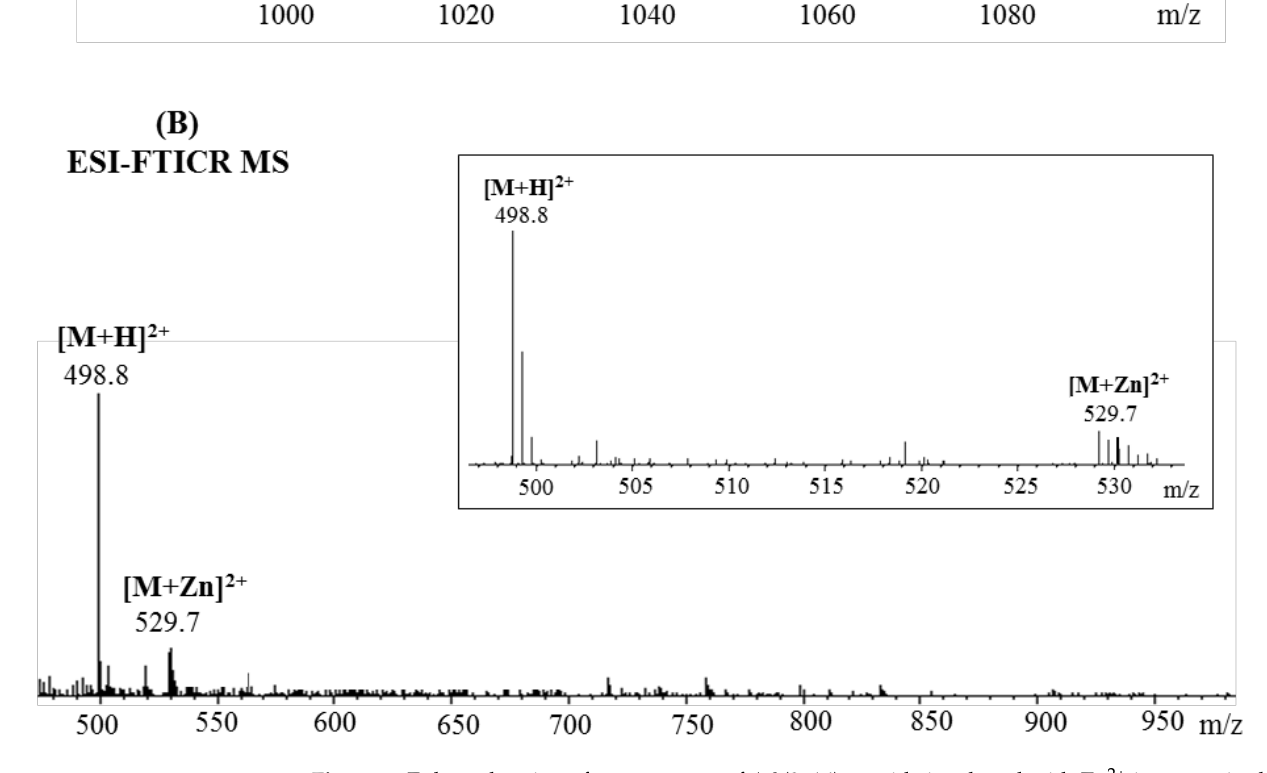
Figure 2. Enlarged region of mass spectra of A β (9–16) peptide incubated with Zn 2+ ions acquired by ( A ) MALDI ToF (reflectron mode) with CHCA matrix and ( B ) ESI-FTICR, both in positive mode. In- serts: ( A ) details of theoretical and experimental isotopic patterns of [M + Zn-H] + and [M + Zn] 2+ ions; ( B ) detail of the double-positive-charged peptide fragments.